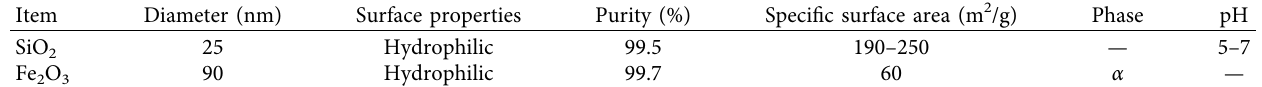
Table 1: Performance of